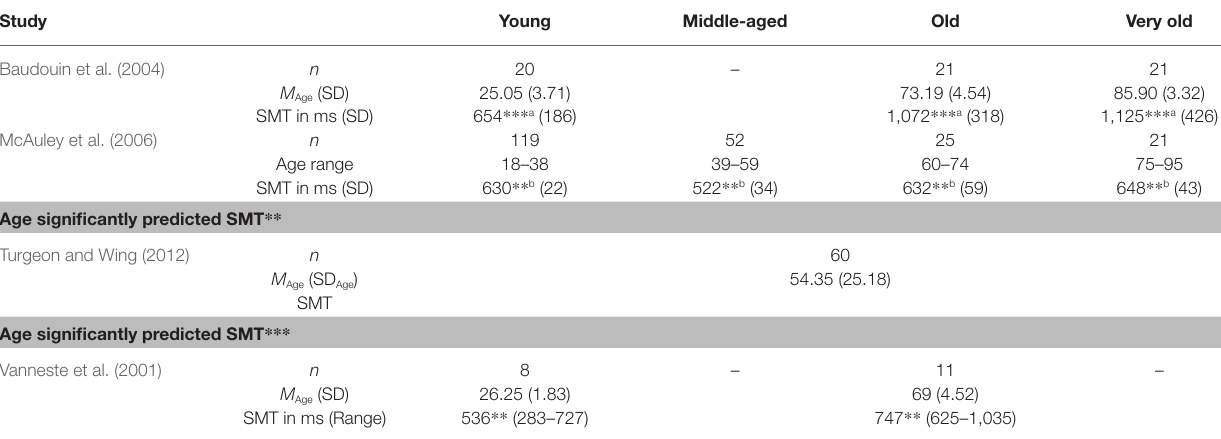
TABLE 1 | Studies investigating spontaneous motor tempo in different age